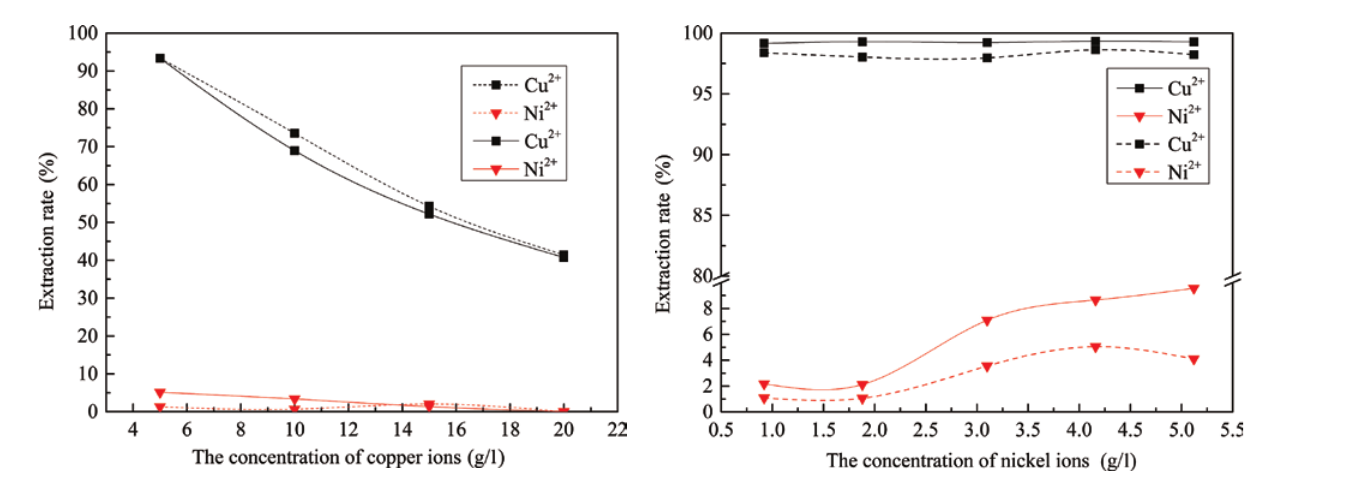
Figure 9: Effect of copper ions concentration on extraction efficiency. ( ) Microfluidic extraction; ( ) conventional extraction.